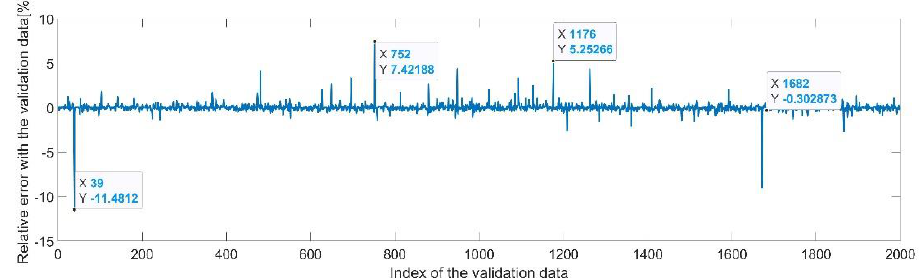
Figure 13. Relative errors between the target values and the predicted values for 𝑞 2 .